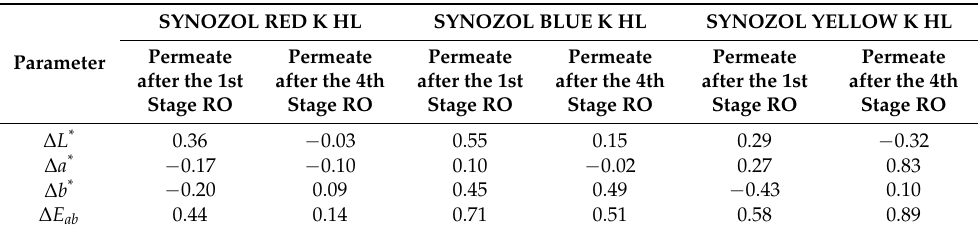
Table 7. Color difference ( ∆ E ab ) of dyed samples with a color intensity of 0.1% in pure water and treated MTW: nonwoven fabric 100%